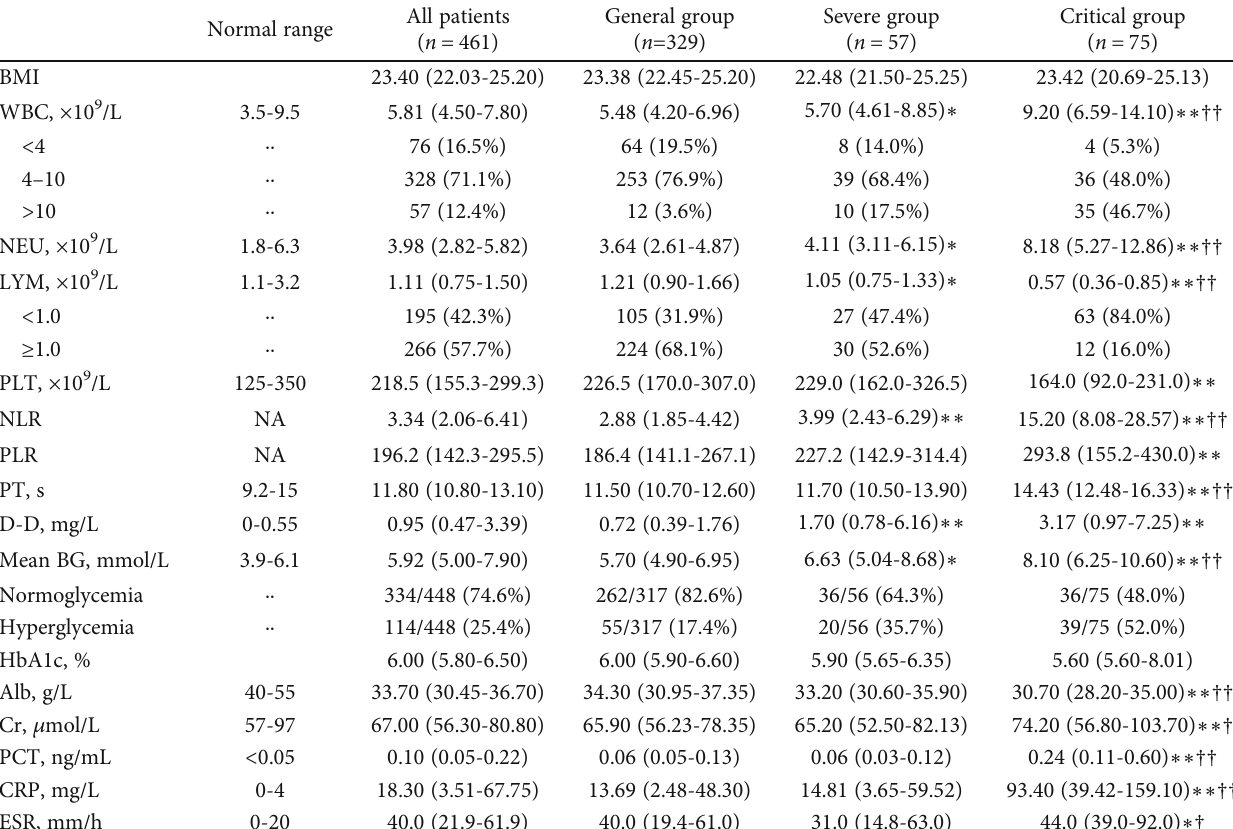
Table 1: Demographics and laboratory fi ndings of COVID-19 patients on admission to